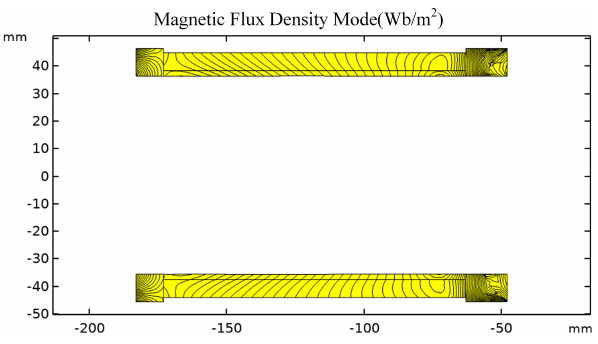
Figure 7. The isopleth map at the working air gap of the macro- motion